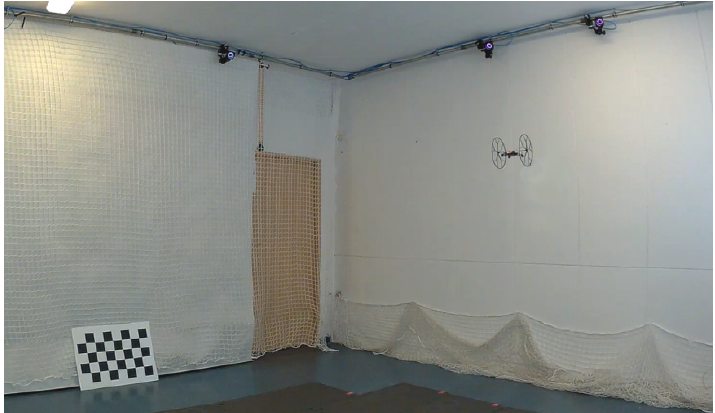
Figure 2. AeroLAB flying arena during the experimental